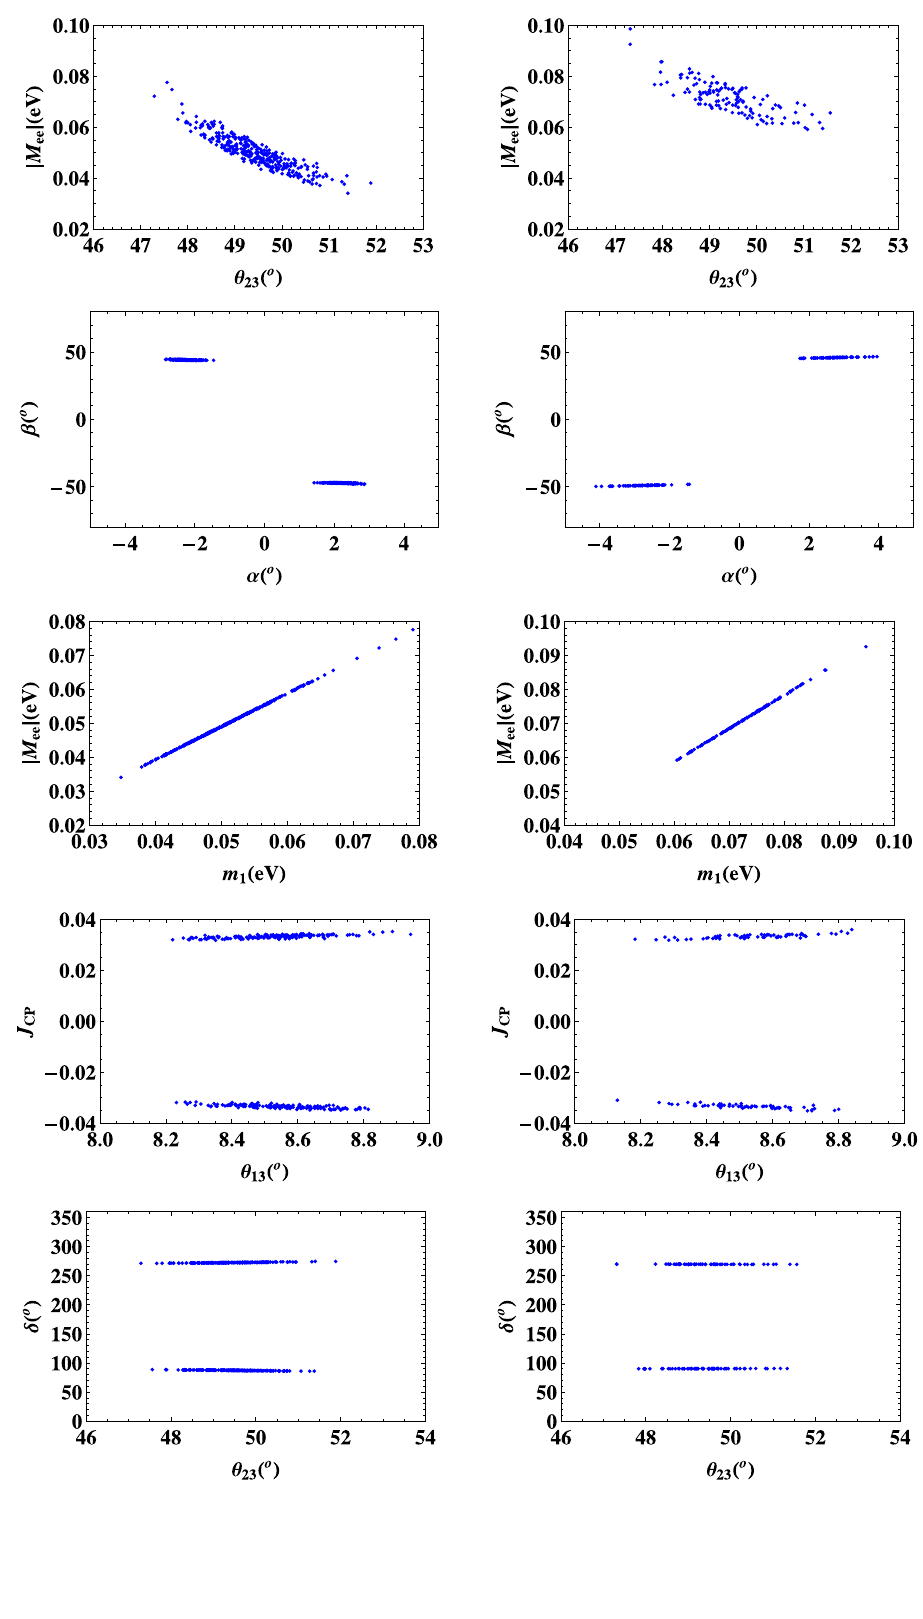
Fig. 3 Correlation plots for textures C 1 -NH (left panel) and C 3 -IH (right panel) under LMA